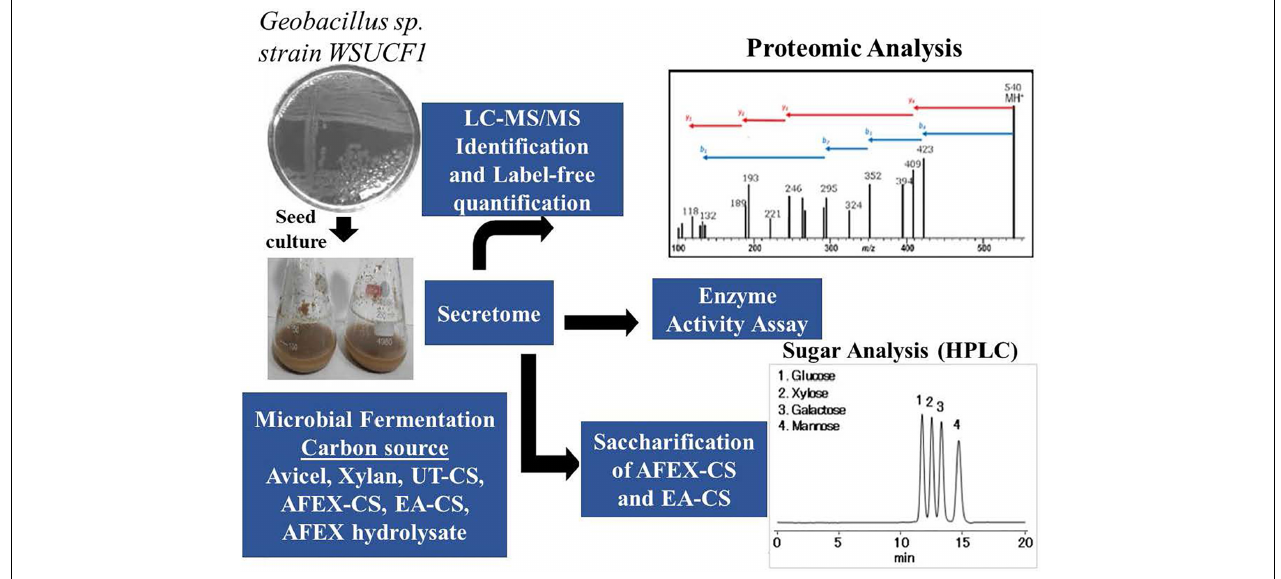
FIGURE 3 | Picture showing how secretome was produced using different substrates and carbon sources and used for proteomic analysis, enzyme activity assay, and saccharification of AFEX-CS and EA-CS.